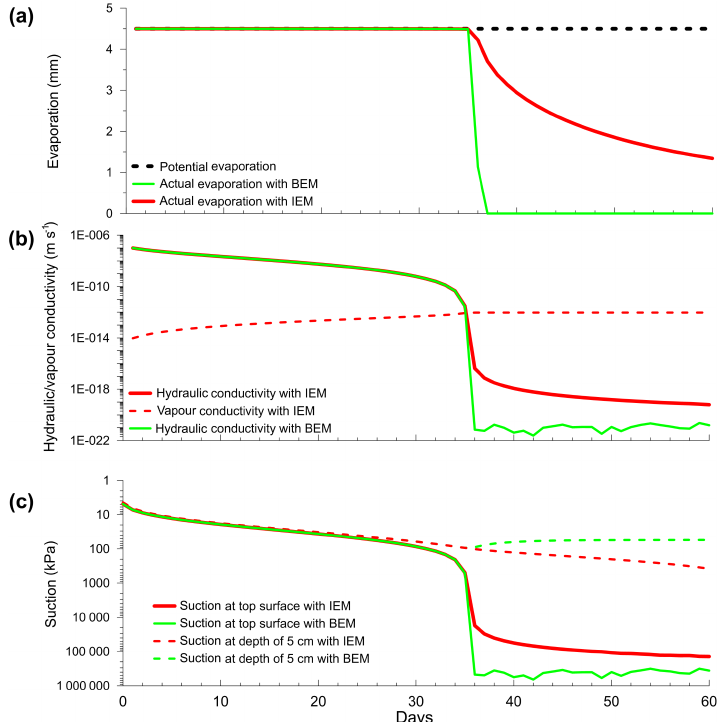
Figure 14. Comparison of variables yielded by IEM and BEM predictions under PE = 4.5mmday − 1 : (a) comparisons between actual evaporative fluxes (AE); (b) comparisons between hydraulic conductivities at the top surface and evolution of vapour conductivity at the top surface; (c) comparisons between evolutions of suction at the top surface and at depth of 5cm.